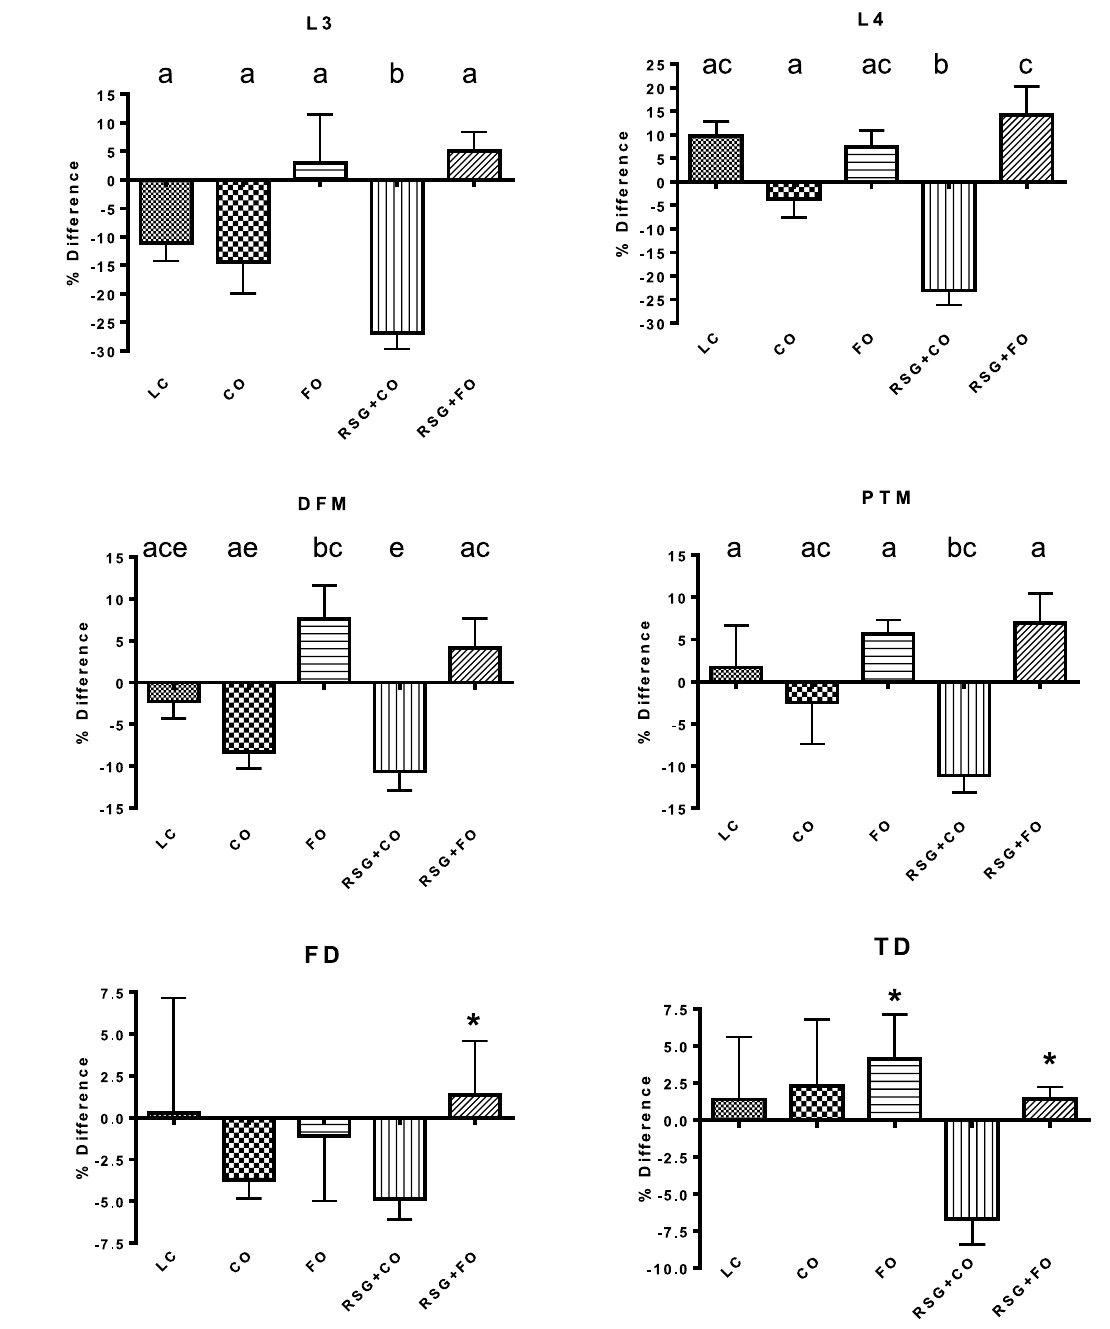
Figure 3. Effect of RSG with or without FO on bone mineral density (BMD) of aging C57BL/6 mice. Thirteen months old C57Bl/6 mice (n = 10) were fed with CO, RSG + CO, FO, RSG + FO, and LC for 5 months. Region-specific BMD was measured by dual-energy x-ray absorptiometry (DEXA) for lumbar vertebra 3 (L3), lumbar vertebra 4 (L4), distal femoral metaphysis (DFM), proximal tibial metaphysis (PTM), femoral diaphysis (FD), and tibial diaphysis (TD). A DEXA scan was performed at 13 months of age just before starting the experimental diets to determine the baseline BMD value. Thirteen-month-old C57Bl/6 mice were fed experimental diets for 5 months and then another DEXA scan was performed to determine the endpoint BMD value. The percent difference in BMD value was analyzed from the endpoint value to the baseline value. Each value represents the mean ± SEM. n = 8–10 mice per group. Values with different letters are significantly different by one-way ANOVA followed by Newman-Keuls multiple comparison post hoc tests (p < 0.05). CO corn oil, RSG rosiglitazone, FO fish oil, LC lab